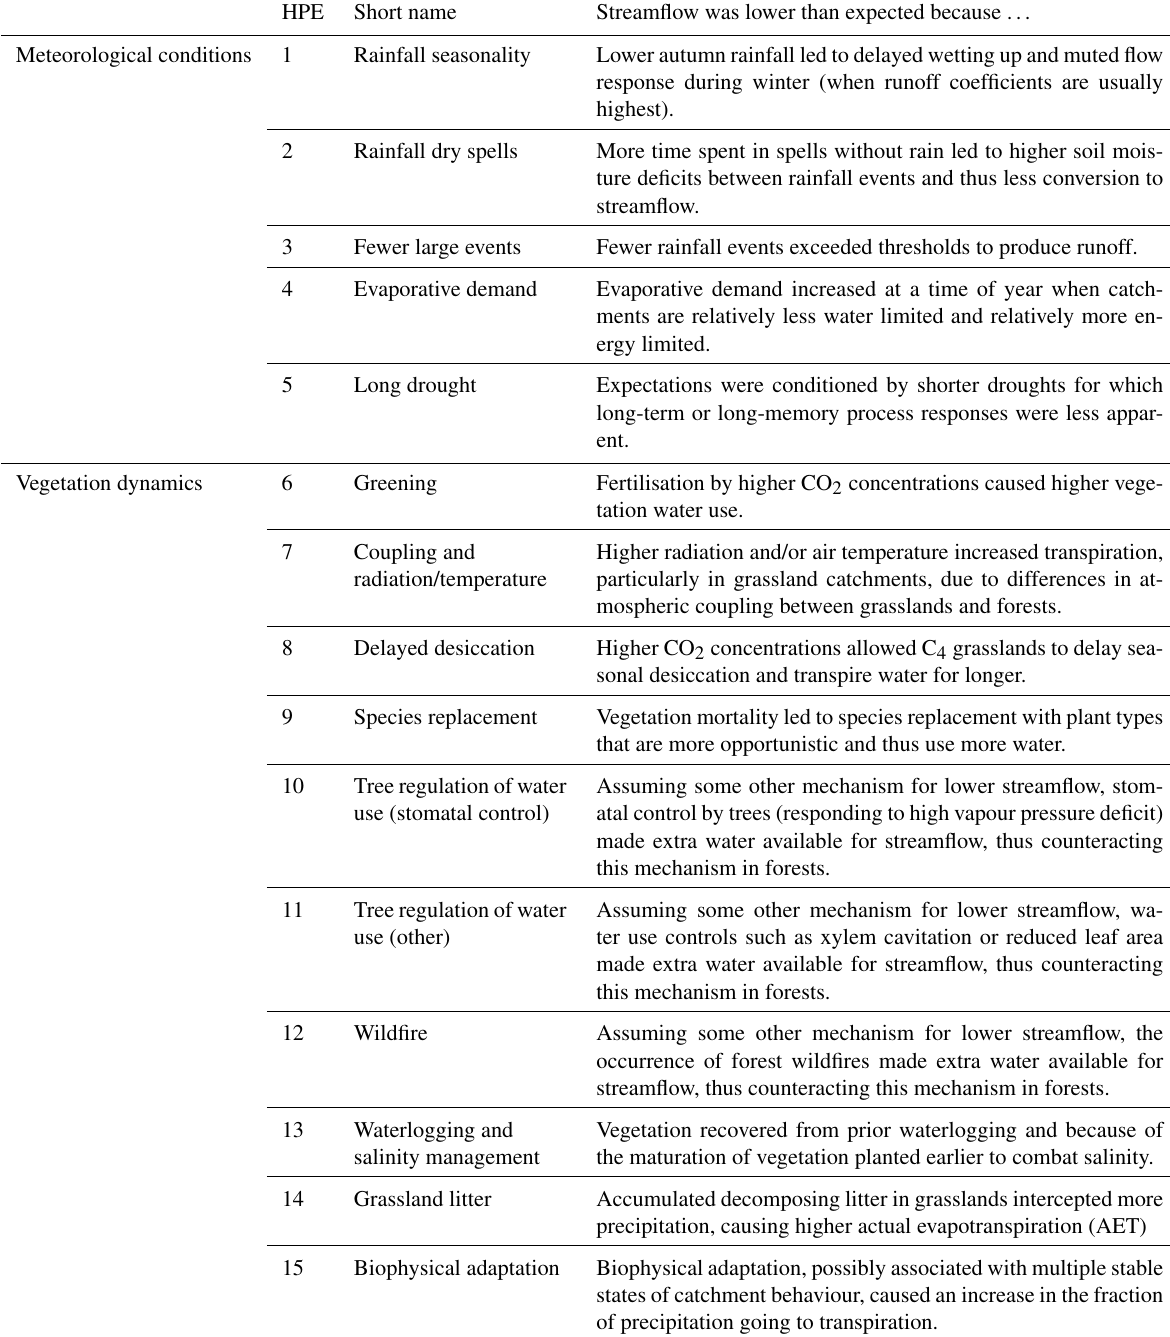
Table 1. Summary table of the hypothesised process explanations (HPEs). Note that HPEs marked with an asterisk ( ∗ ) also assume declines in recharge, e.g. due to lower precipitation, and/or HPEs 6–7, 9, or